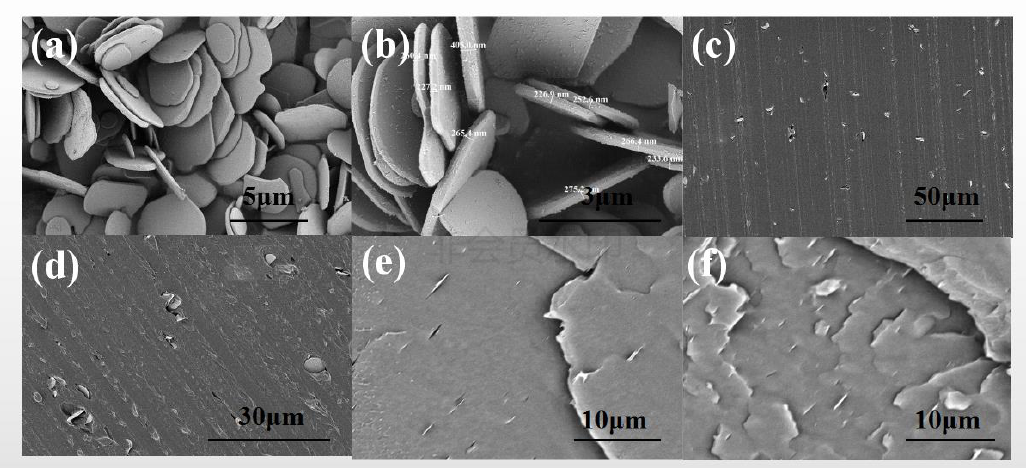
Figure 5. SEM images of ( a , b ) uncoated α -Al 2 O 3 nanosheets, ( c , d ) the cross-section of crosslinked polyethylene (XLPE) / coated α -Al 2 O 3 nanocomposites and XLPE / uncoated α -Al 2 O 3 nanocomposites containing 2.0 wt % α -Al 2 O 3 nanosheets and ( e , f ) the cross-sections of the nanocomposite specimens containing 1.0 wt % and 2.0 wt% α -Al 2 O 3 nanosheets after the liquid nitrogen quenching section.